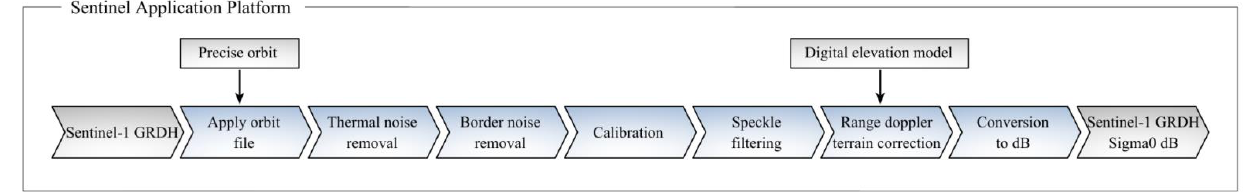
Figure 2. Sentinel-1 data preprocessing steps.